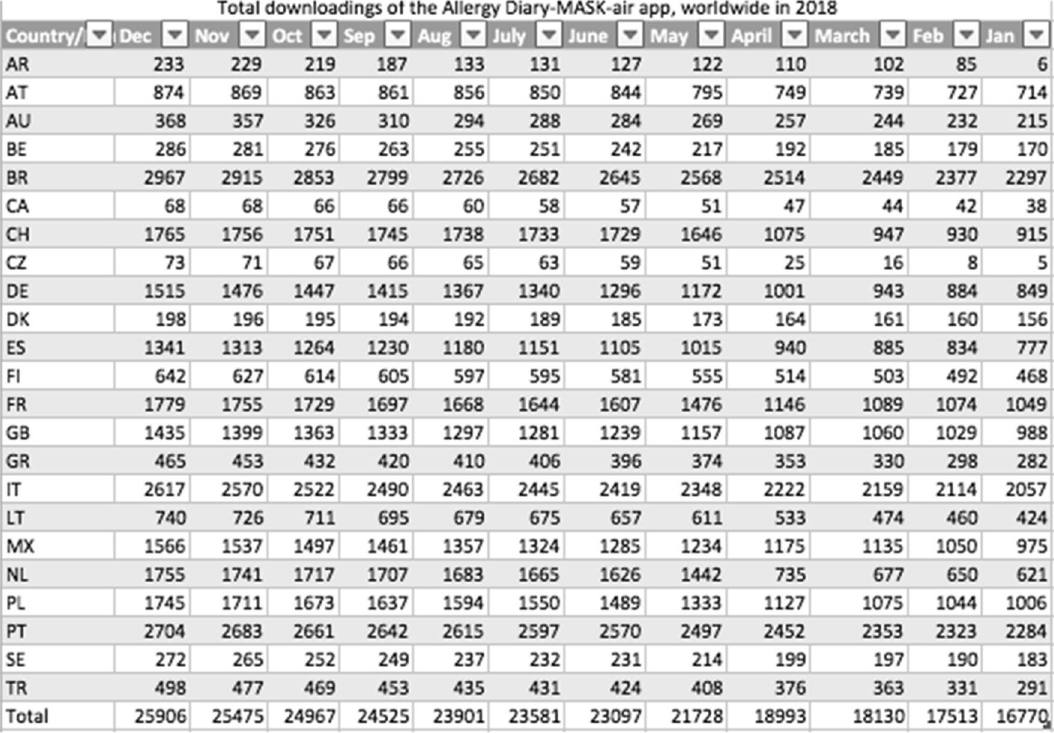
Table 2 List of countries using